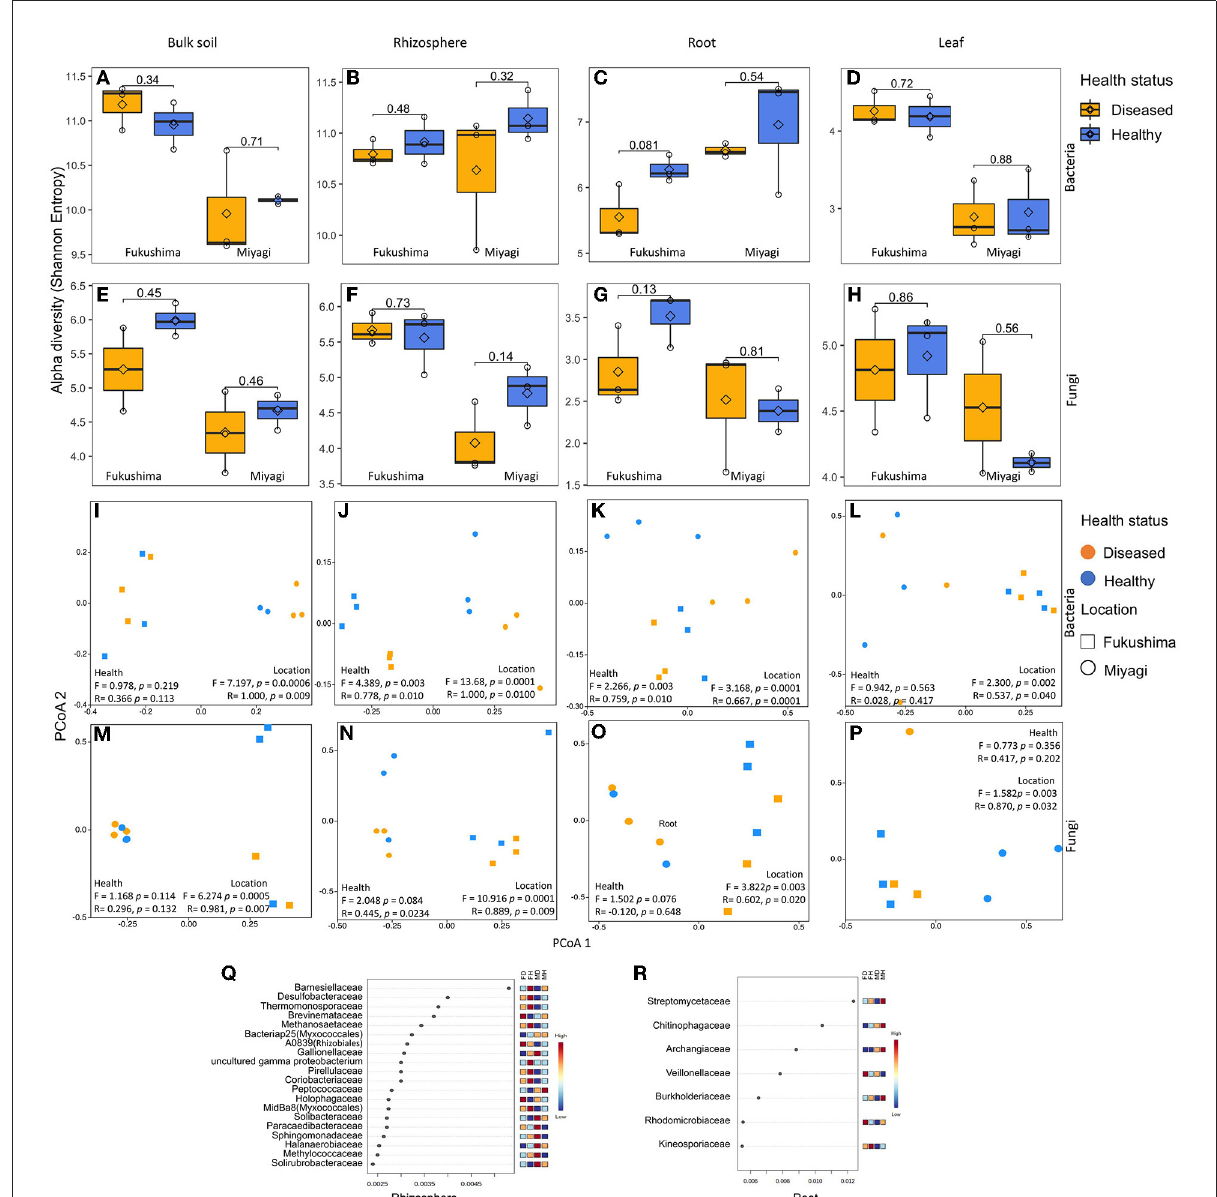
FIGURE1 Bacterial and fungal microbiome community of rice as influenced by plant health status and location: Alpha diversity (Shannon Entropy) of bacterial (A–D) and fungal (E–H) community in bulk soil (A,E) , rhizosphere soil (B,F) , root endosphere (C,G) , and leaf endosphere (D,H) . Principal co-ordinate (PCoA), analysis of similarity (ANOSIM), and permutational multivariate analysis of variance (PERMANOVA)-based analyses of bacterial (I–L) and fungal (M–P) microbiome of healthy and diseased (non-symptomatic) samples of rice collected from two locations in Japan. Bray-Curtis coefficient of community similarity index was computed for comparing the bacterial community similarity among groups. The ANOSIM statistic R values (up to 1) and PERMANOVA pseudo-F indicate similarity/dissimilarity between groups. Ordination plots show the influence of plant health status, and location on microbial community assembly of bulk soil (I,M) , the rhizosphere soil (J,N) , root endosphere (K,O) , and the leaf endosphere (L,P) . Differential abundance of bacterial microbiome community of rhizosphere soil (Q) and root endosphere (R) rice as obtained by random forest analysis. Random forest analysis results of top 20 bacterial family with the highest discriminatory power between diseased and healthy samples of rhizosphere community are shown. Red fields show a high abundance and blue fields a low abundance of the particular bacterial family. FD, Fukushima diseased; FH, Fukushima healthy; MD, Miyagi diseased; MH, Miyagi